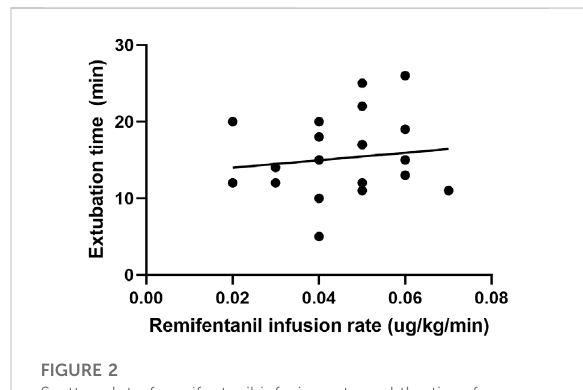
FIGURE 2 Scatter plot of remifentanil infusion rate and the time for extubation in the cough suppression group.